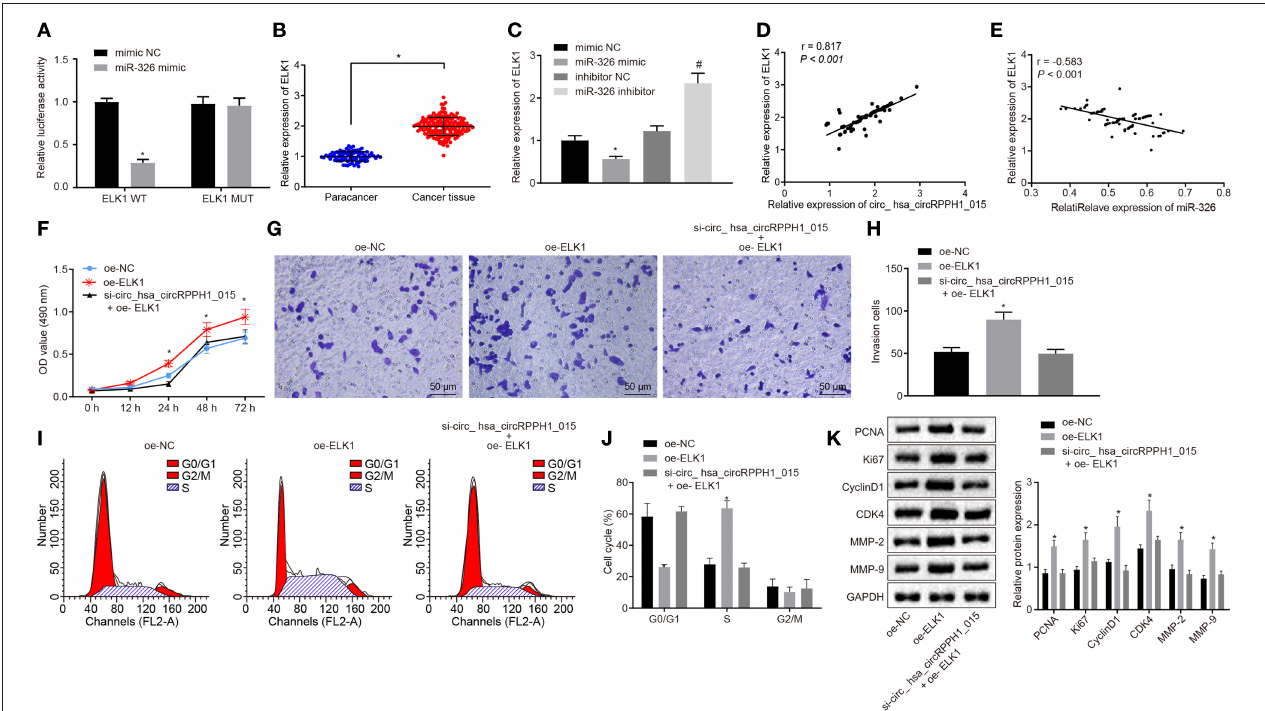
FIGURE 6 | Regulation of ELK1 via miR-326 by hsa_circRPPH1_015 contributes to the development of BC. (A) The targeting relationship between miR-326 and ELK1 verified by dual-luciferase reporter gene assay. (B) The expression of ELK1 in BC tissues ( n = 86) and adjacent normal tissues ( n = 86) examined by RT-qPCR. (C) The expression of ELK1 in MCF-7 cells of each group examined by RT-qPCR. (D) The correlation analysis between hsa_circRPPH1_015 and ELK1. (E) The correlation analysis between miR-326 and ELK1. (F) The proliferation of MCF-7 cells in each group assessed by EdU assay. (G,H) The cell migration ability of MCF-7 assessed by Transwell assay ( × 200). (I,J) The distribution of MCF-7 cell cycle in each group detected by flow cytometry. (K) The expression of associated proteins normalized to GAPDH in each group determined by Western blot analysis. * p < 0.05 vs. the mimic NC group (MCF-7 cells transfected with mimic NC). # p < 0.05 vs. the si-NC group (MCF-7 cells transfected with si-NC), the oe-NC group (MCF-7 cells transfected with oe-NC), or the inhibitor NC group (MCF-7 cells transfected with inhibitor NC). The quantitative analysis results were measurement data and compared by unpaired t -test between two groups and by one-way ANOVA among multiple groups. Values were obtained from three independent experiments. BC, breast cancer; ELK1, ETS-domain containing protein; EdU, 5-ethynyl-2 ′ -deoxyuridine; RT-qPCR, reverse transcription quantitative polymerase chain reaction; GAPDH, glyceraldehyde-3-phosphate dehydrogenase; si-NC, small interfering RNA-negative control; oe, overexpression; ANOVA, analysis of